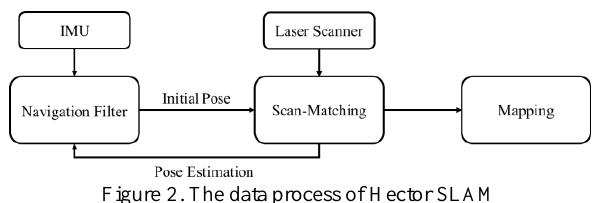
Figure 2. The data process of Hector